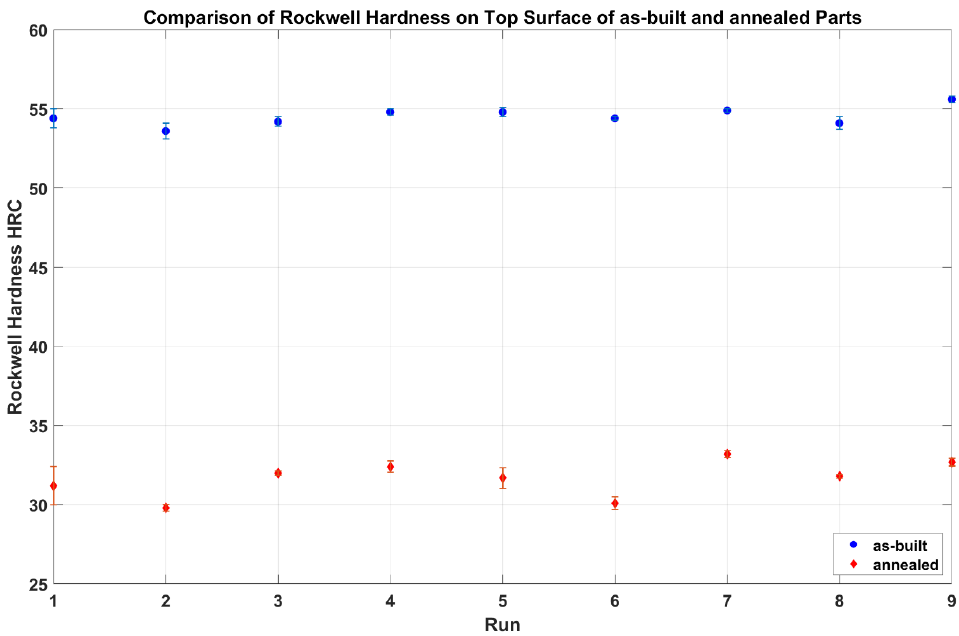
Figure 16. Effect of annealing on Rockwell hardness HRC on the top surface.